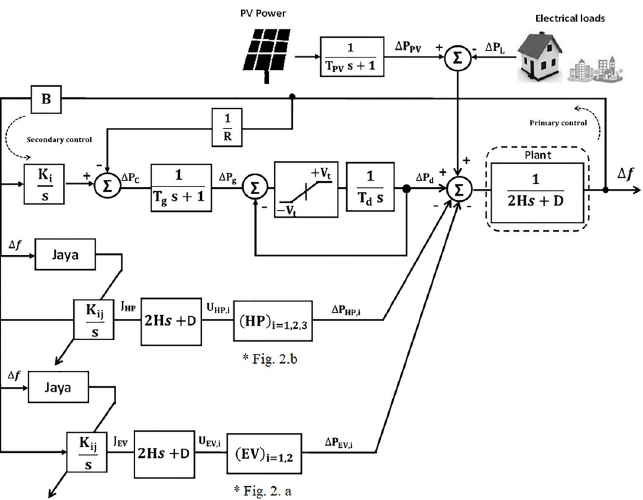
Fig 9. Overall islanded μ G system block diagram considering participation of flexible loads (EVs and HPs) based on the adaptive Jaya optimizer.